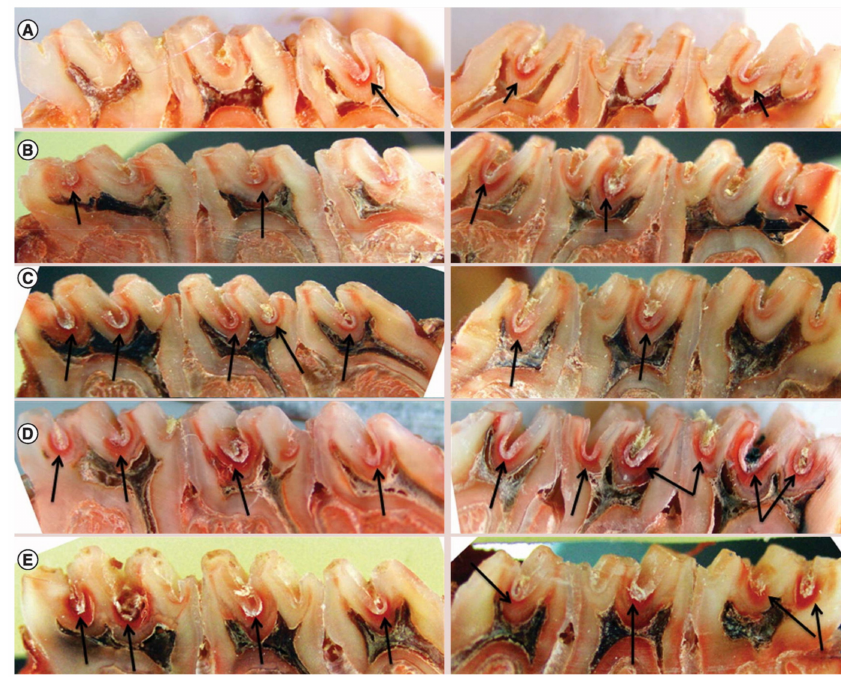
Figure 4. Micrograph showing rat molars after murexide staining and hemisectioning in the mesiodis- tal sagittal plane. ( A ) The pVAX1-wapA/CSTM NPs intranasal group; ( B ) pVAX1-wapA/CSTM NPs intramuscular group; ( C ) pVAX1wapA intramuscular group; ( D ) pVAX1/CSTM NPs intranasal group; ( E ) pVAX1/CSTM NPs intramuscular group. Arrows indicate the caries lesions. Adapted with permission from Li et al.